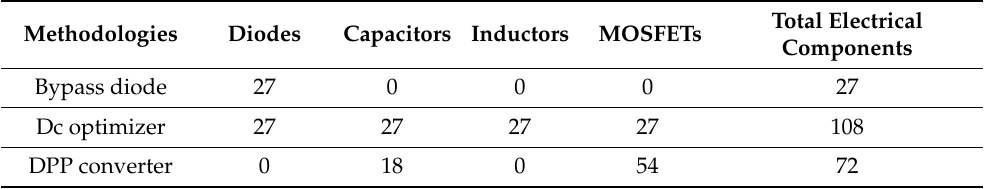
Table 7. Number of components required for 2.2 kW system containing nine 245 W PV modules and equipped with bypass diodes, DC optimizers, or DPP